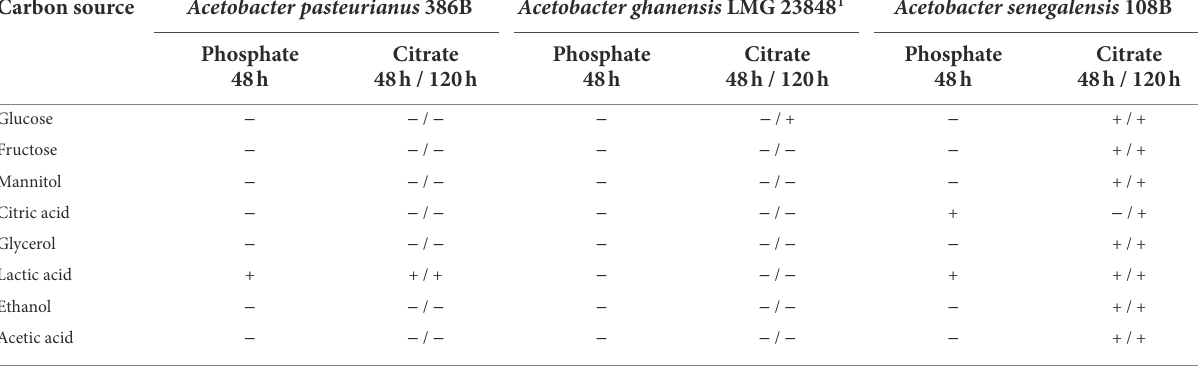
TABLE 1 Indication of bacterial population growth of strains of three different Acetobacter species in a modified defined medium with phosphate buffer or citrate buffer, supplemented with different carbon sources, after 48 h and 48 and 120 h of incubation,